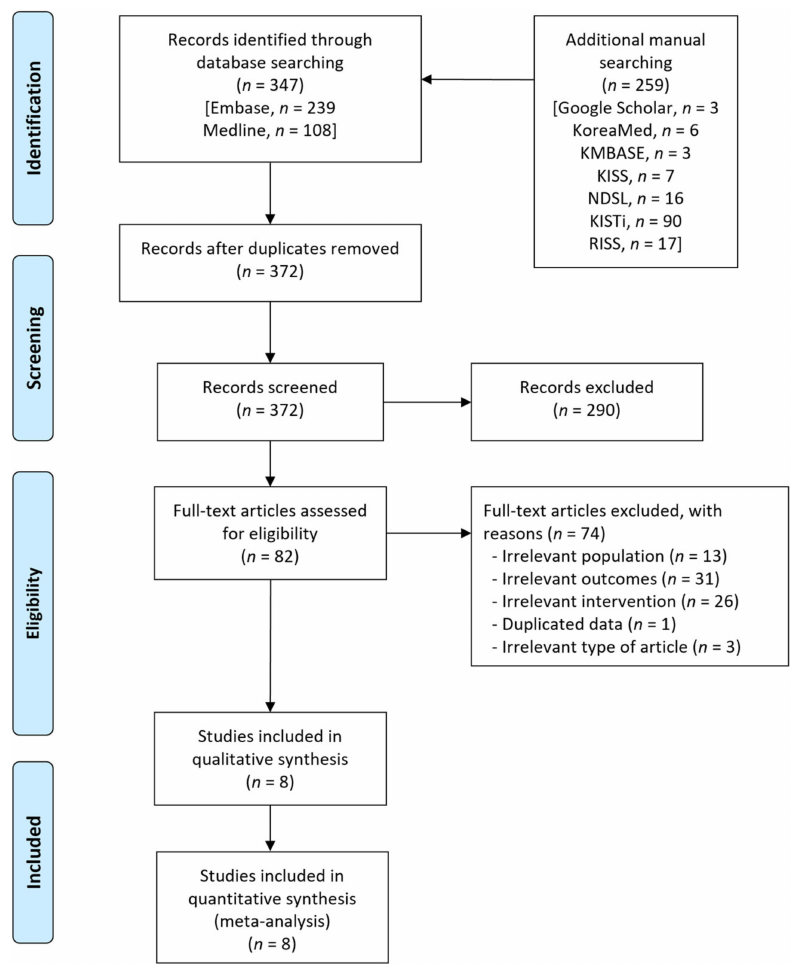
Figure 1. Flow diagram for the identification of relevant